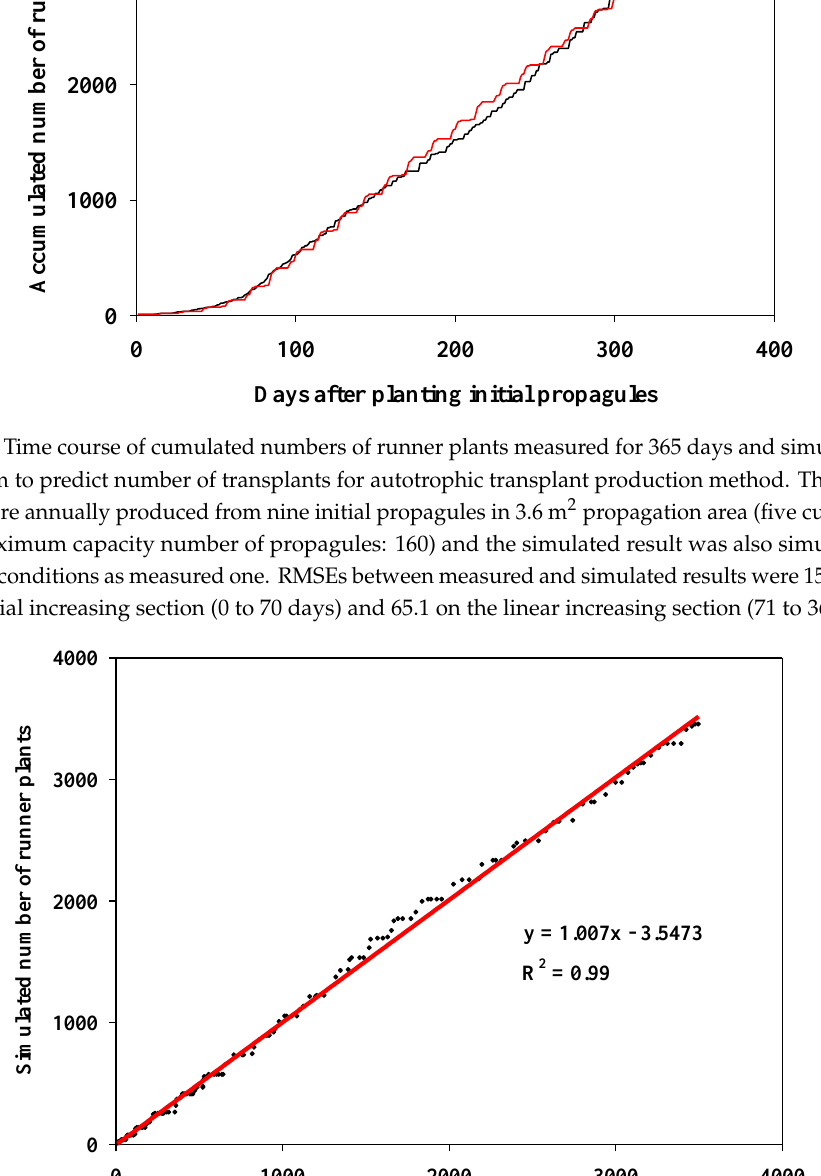
Figure 5. Measured and simulated numbers of runner plants for 365 days at same time. Simulated results were derived from a program to predict number of transplants for autotrophic transplant production method. The runner plants were annually produced from nine initial propagules in 3.6 m 2 propagation area (five cultivation beds; maximum capacity number of propagules: 160) and the simulated result was also simulated by the same conditions as measured one. Propagation cycles used for the program were 15, 27 and 43. The coe ffi cients of determination were estimated by regression